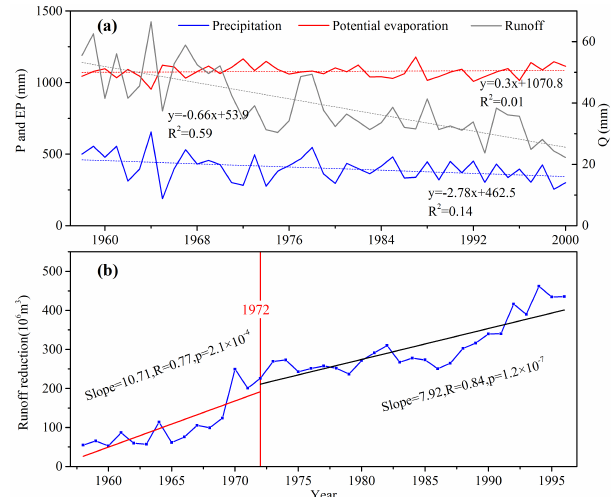
Figure 8. (a) Yearly precipitation, potential evaporation and runoff in Wudinghe basin during the period of 1958–2000; (b) Runoff re- duction in Wudinghe basin caused by all the soil and water conser- vation measures, i.e., land terracing, tree and grass plantation and check dam and reservoir construction for the period of 1958–1996. Note that the data are from Wang and Fan (2003) and are only avail- able from 1956 to